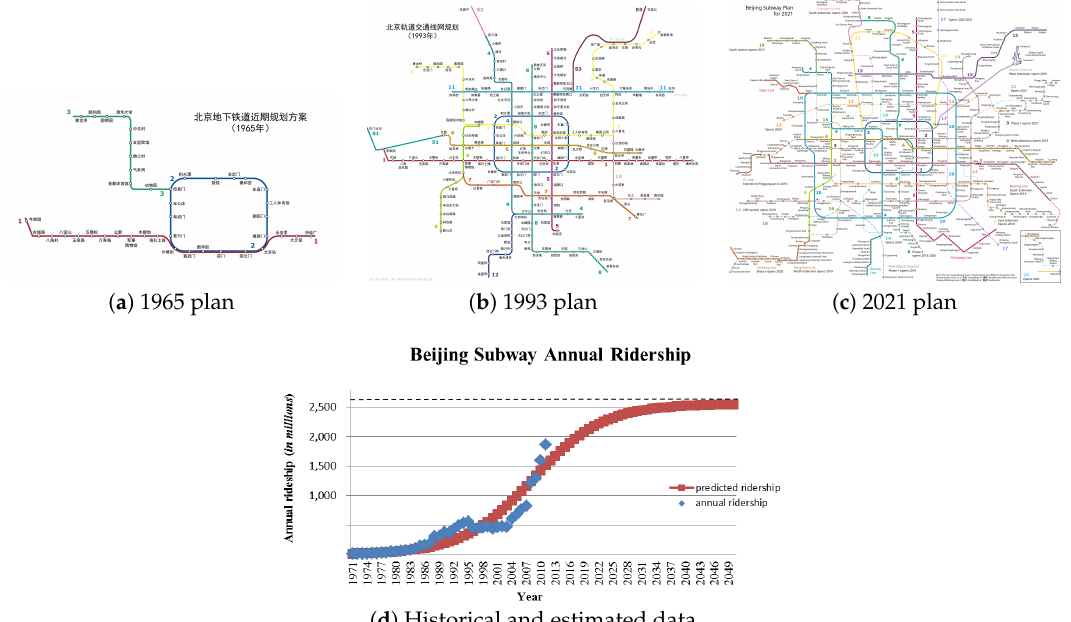
Figure 2. Beijing Subway estimated growth between the years 1970 and 2021. ( a ) Schematic map of Beijing Subway lines in 1965. ( b ). Lines in operation by 1995. ( c ) A map showing Beijing subway lines in operation by the end of 2017 (solid lines) and subway lines then projected for completion before the end of 2021 (dashed lines). ( d ) Historical and estimated